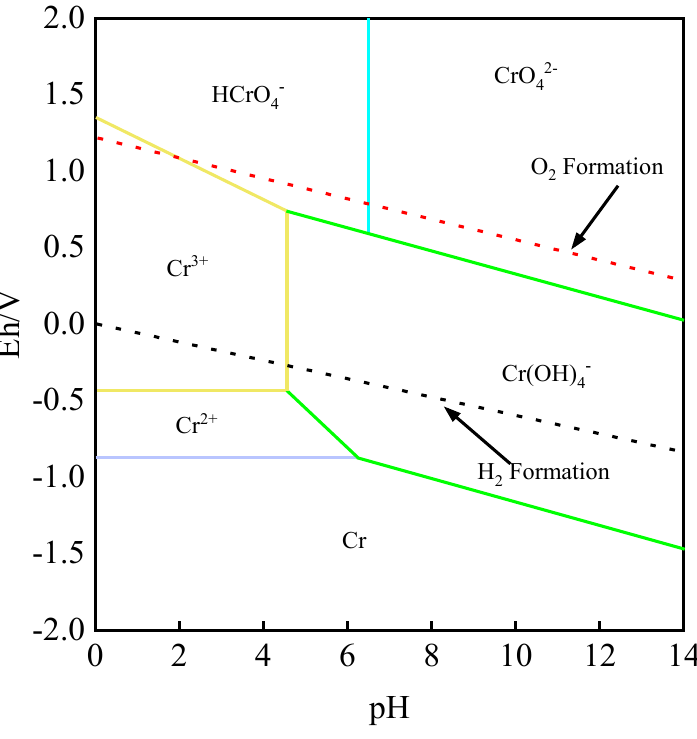
Cr(OH) 2+ complex, it mainly exists in a stable state in the passivation region. In an acidic environment with pH < 4.5, Cr also exists in a stable state in the passivation region in the form of Cr 3+ in a large area. Therefore, when adjusting the Eh and pH values in the leaching solution, attention should be paid to the existing form of Cr in the leaching solution to avoid the negative impact of Cr on the enrichment and separation of the leaching solution.